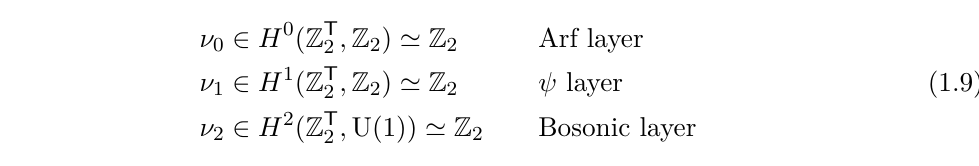
Ω 2 = Z [45]. The anomaly arises from three 8 pin −